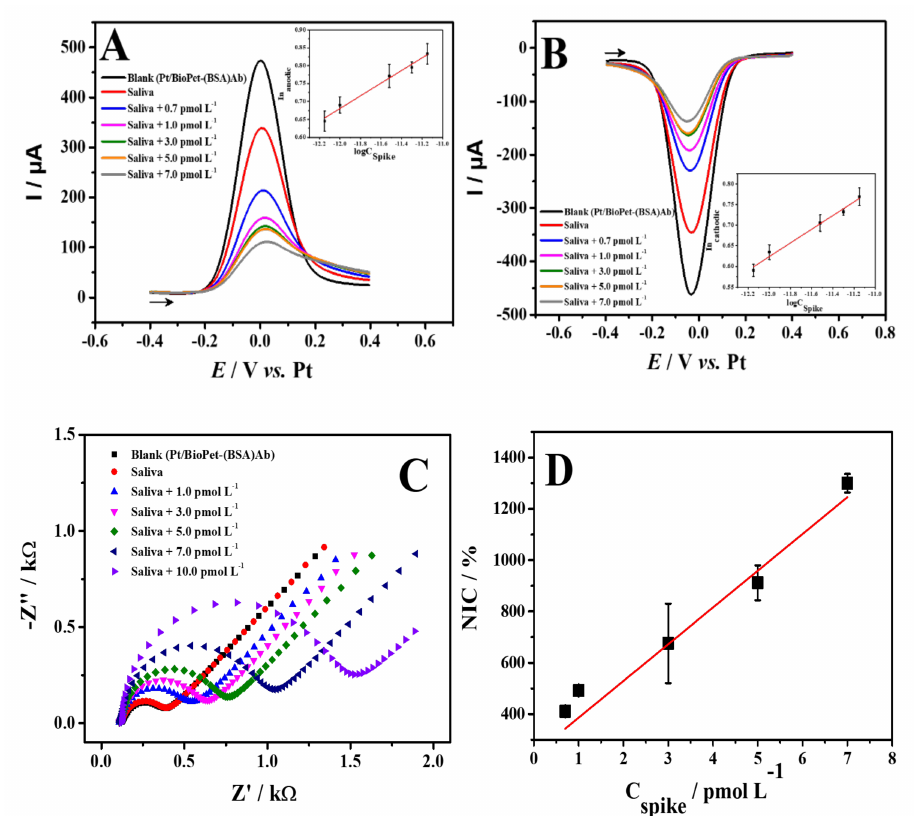
Figure 6. Square wave voltammograms direct ( A ) and reverse ( B ) obtained for different concentra- tions of spike protein of 0.7 − 7.0 pmol L − 1 in the saliva sample. Inset: Plot of peak current versus spike protein concentration. SWV experimental conditions: pulse amplitude: 80 mV; frequency: 80 Hz; step potential: 10 mV. ( C ) Nyquist plots obtained for different concentrations of Spike protein of 1.0 − 30.0 pmol L − 1 in the saliva sample. ( D ) Plot of spike protein concentrations versus